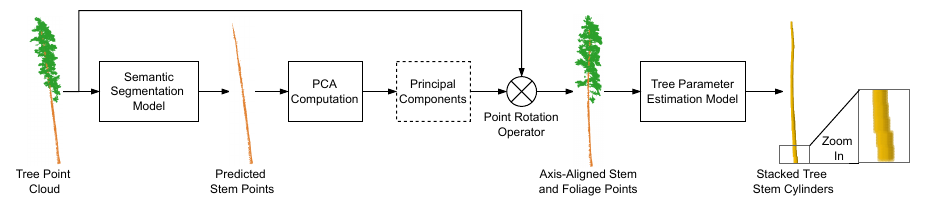
Figure 1. Pipeline of our overall method containing point cloud semantic segmentation and tree parameter estimation. First, we segment the stem points from the input tree point cloud using our segmentation model, then we compute the PCA transform using the stem points and apply the PCA transform to the whole input tree point cloud containing both the stem and foliage points. Finally, we pass the transformed tree point cloud through our DNN-based tree parameter estimation to obtain the tree